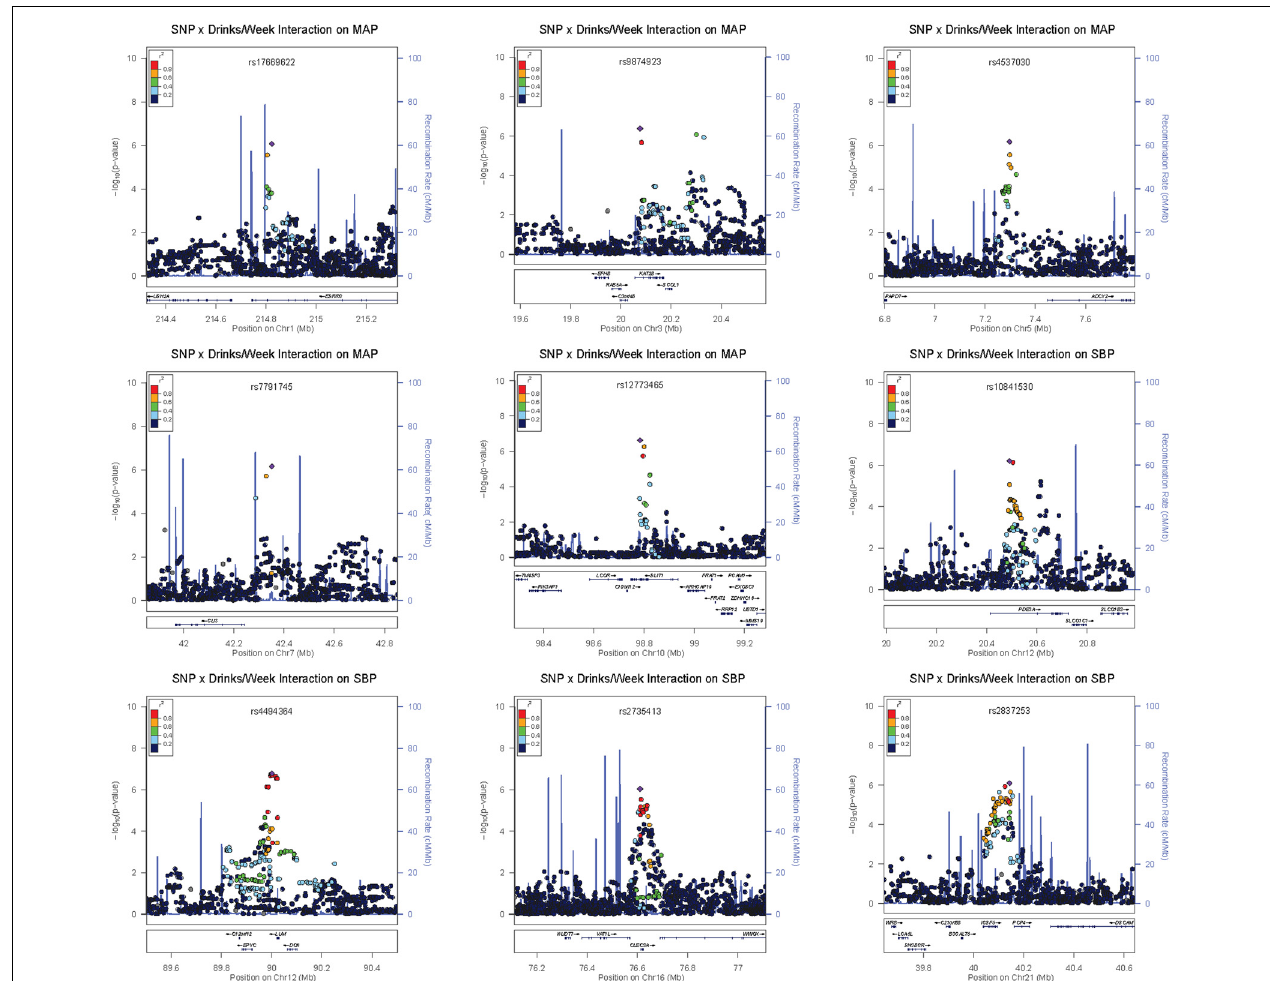
FIGURE 3 | Regional association plots for selected suggestive loci.